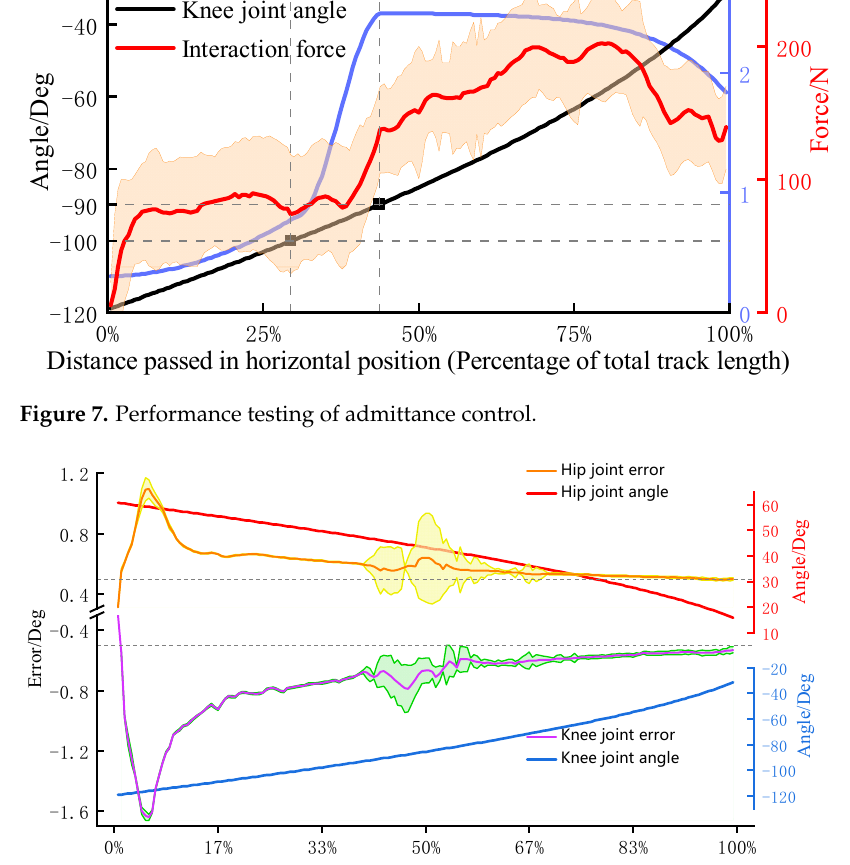
Figure 7. Performance testing of admittance control.